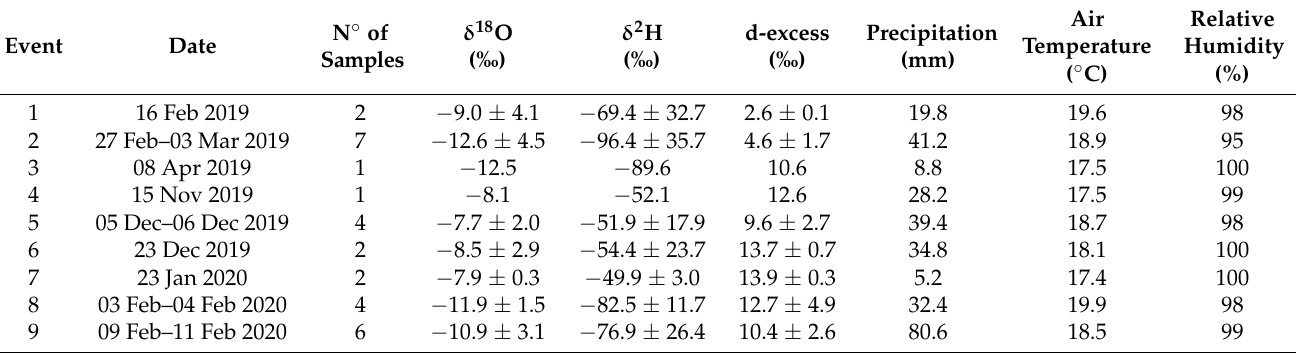
Table 3. Weighted average isotopic composition of precipitation in each South Atlantic Convergence Zone (SACZ) event and precipitation values, air temperature, and relative